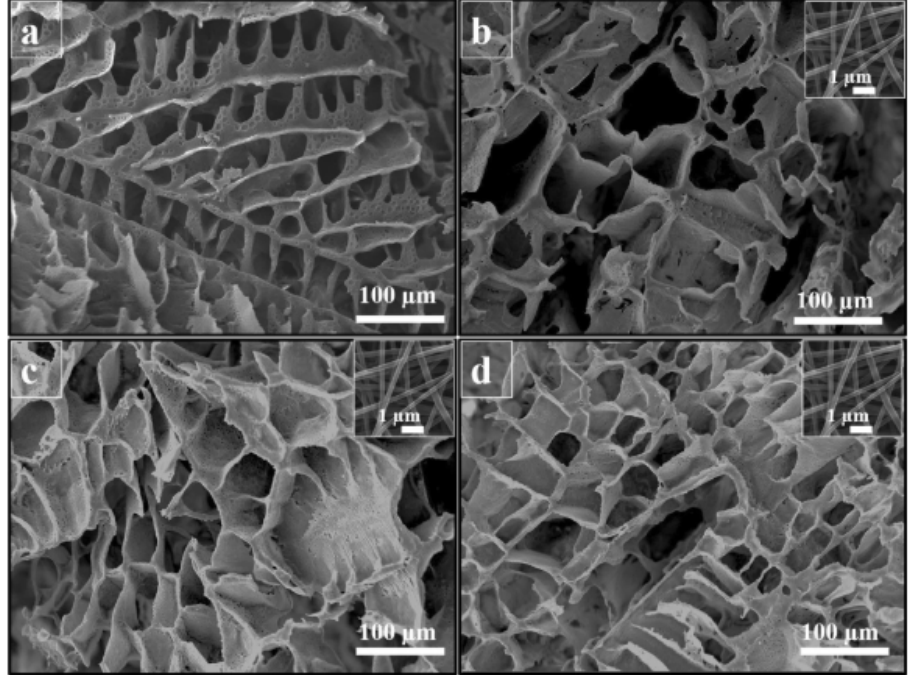
Figure 8. SEM micrograph of the prepared scaffolds. ( a ) PCL/PLA/GNF, ( b ) PCL/PLA/GNF/Tau 0.1%, ( c ) PCL/PLA/GNF/Tau 1%, and ( d ) PCL/PLA/GNF/Tau 10%. The insets show SEM micro- graph of GNFs [106]. Reprint with permission from Springer Nature.